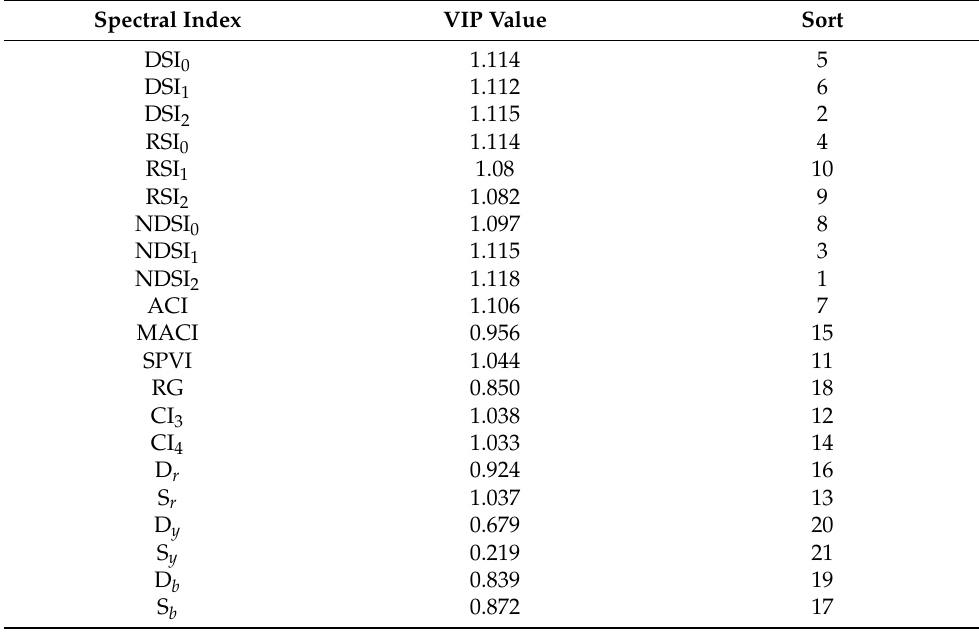
Table 3. VIP Value and sorting of spectral